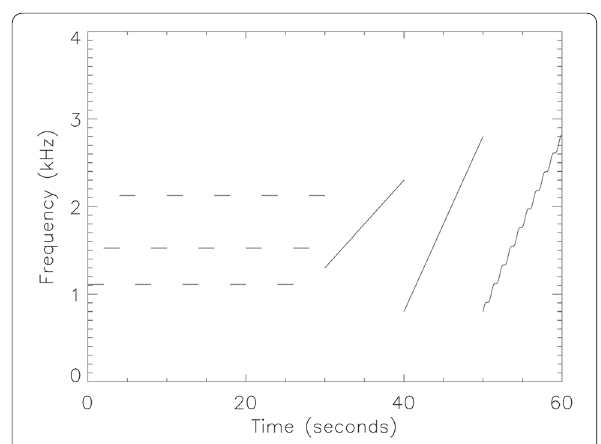
Fig. 22 Pulses and ramps triggered by HAARP during the case